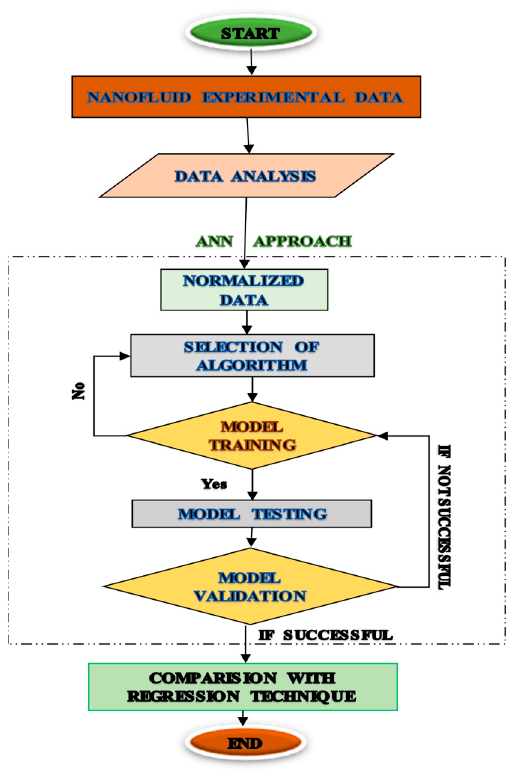
Figure 2. Methodology of the proposed Artificial Neural Network (ANN).